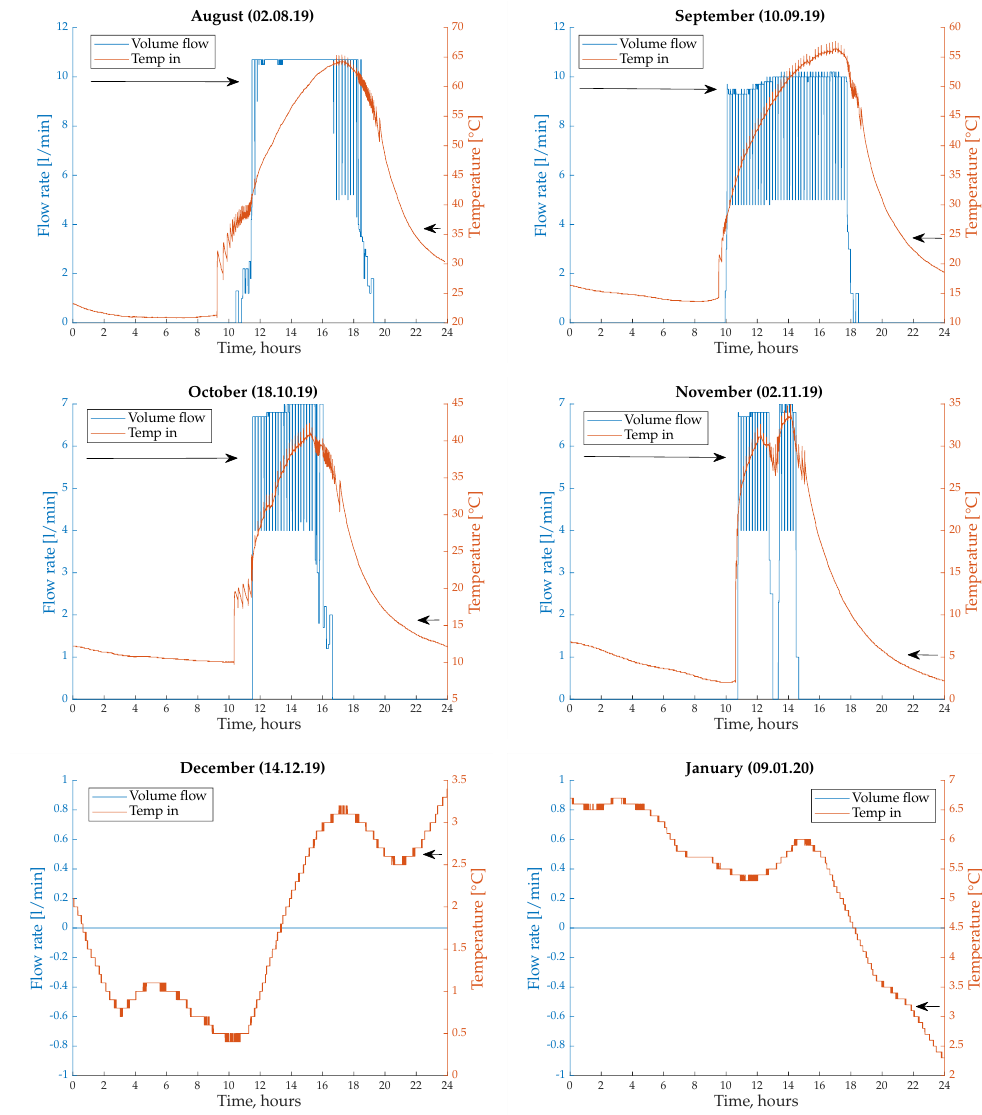
Figure 4. Examples of collector logs for 6 selected dates in